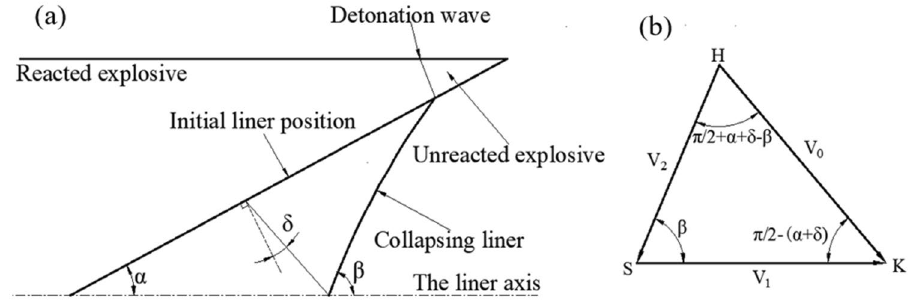
Figure 20. ( a ) Schematic of the collapse process; ( b ) velocity vectors in a moving system.